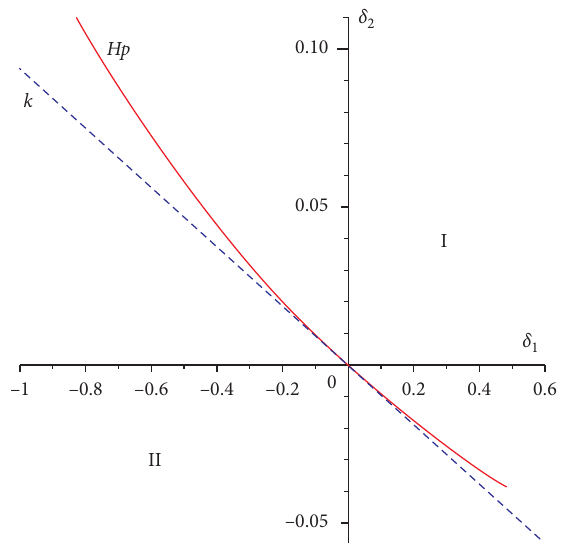
Figure 6: Hopf bifurcation curve Hp (in red) in Example